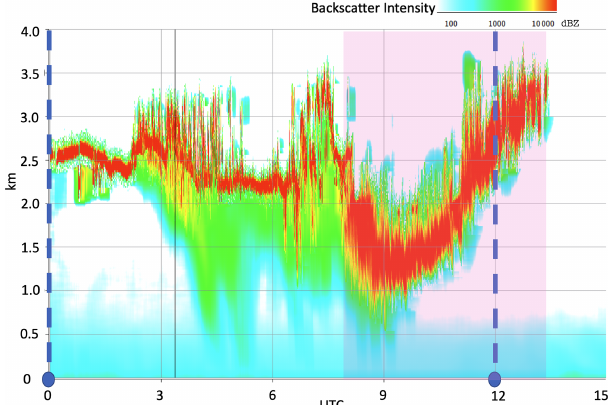
Figure 1. Aerosol backscatter profile obtained from CL31 for 25 January 2017, from 00:00–15:00UTC, showing virga occur- rence from 08:00 to 13:00UTC (shaded region). The dashed blue lines and circles indicate the availability of radiosonde